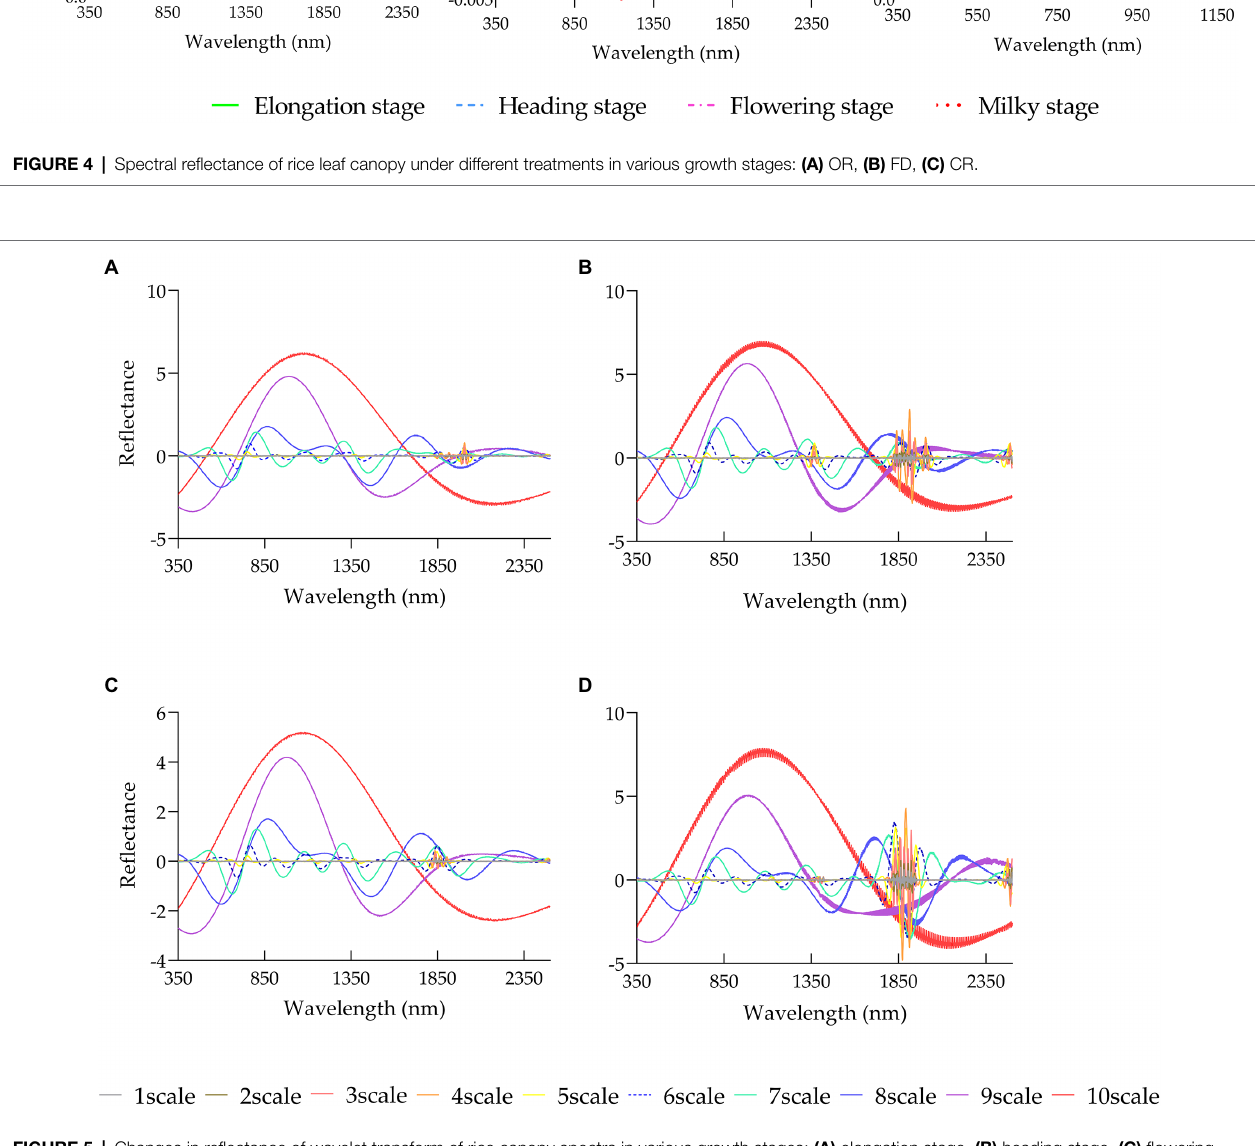
FIGURE 5 | Changes in reflectance of wavelet transform of rice canopy spectra in various growth stages: (A) elongation stage, (B) heading stage, (C) flowering stage, (D) milky